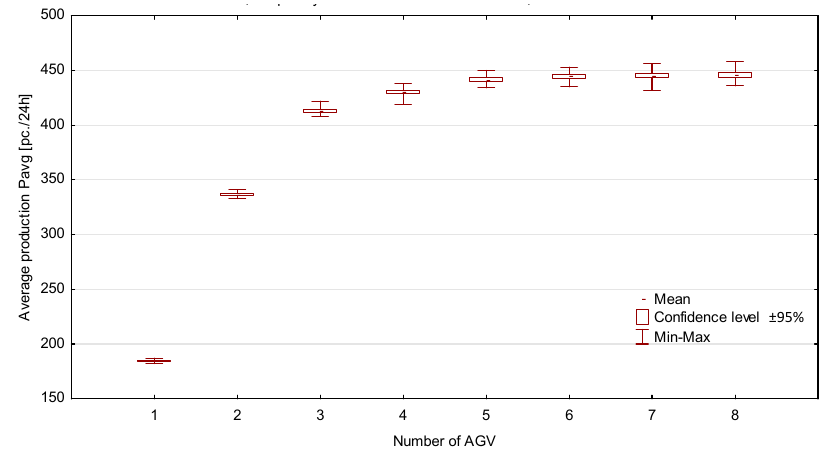
Figure 4. The relationship between average production Pavg and the number of AGV used for 24 h of simulation. Table 1. The results of simulation experiments (Average production completed P avg , in [pieces] for 24 h of work, 30 simulation runs in each experiment, 95% confidence level).